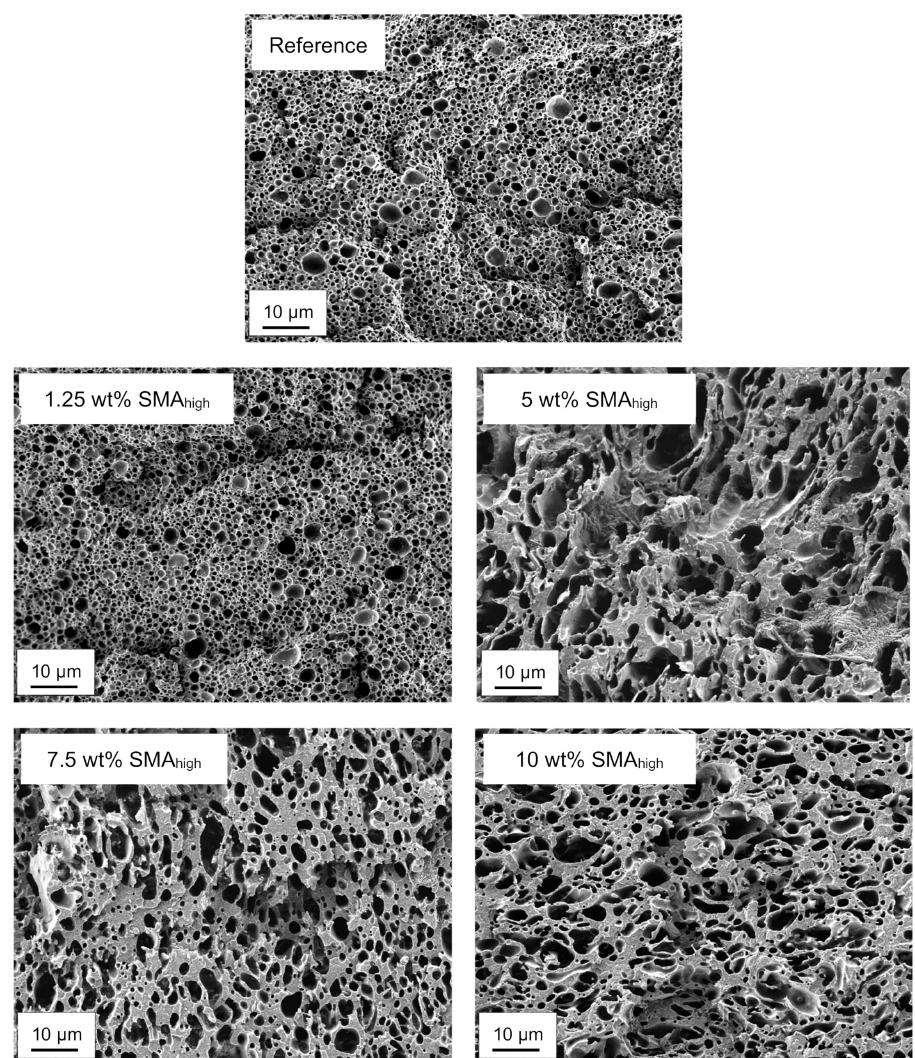
Figure 4. SEM micrographs of selectively etched PA66 / PPE / SMA high ternary